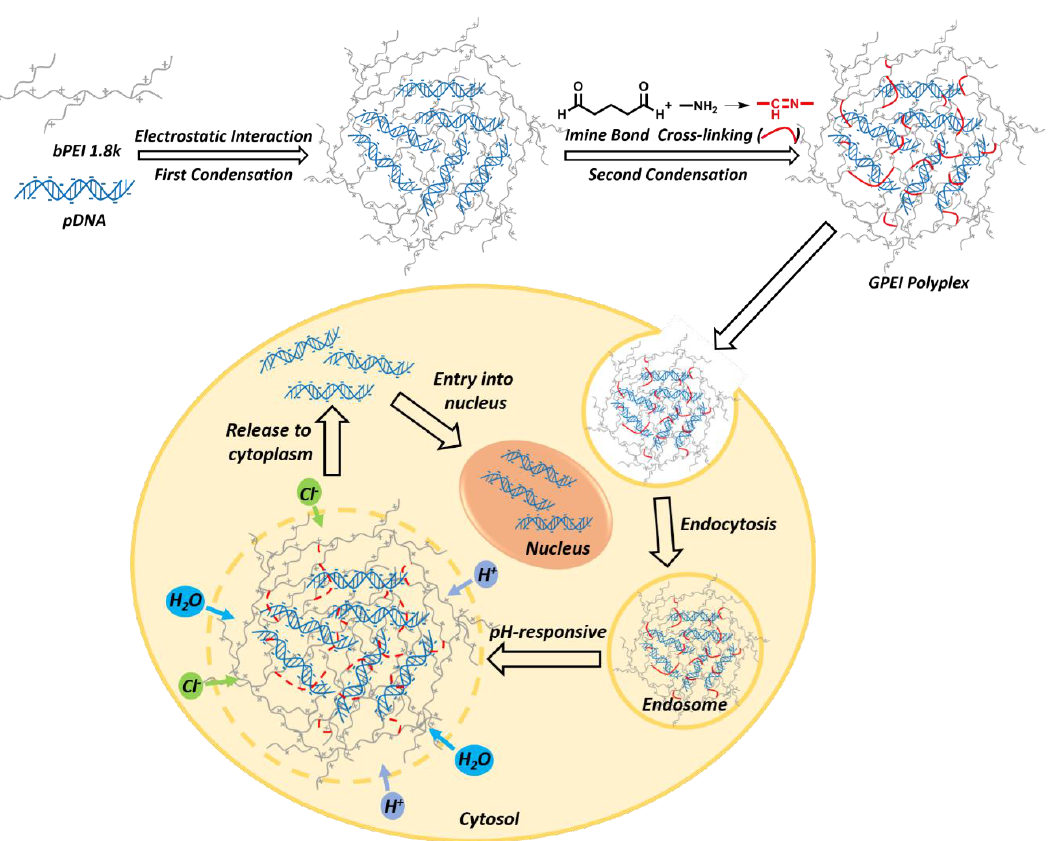
Figure 1. Schematic illustration showing the construction and delivered process of glutaraldehydelinked-branched PEI (GPEI) polyplex.